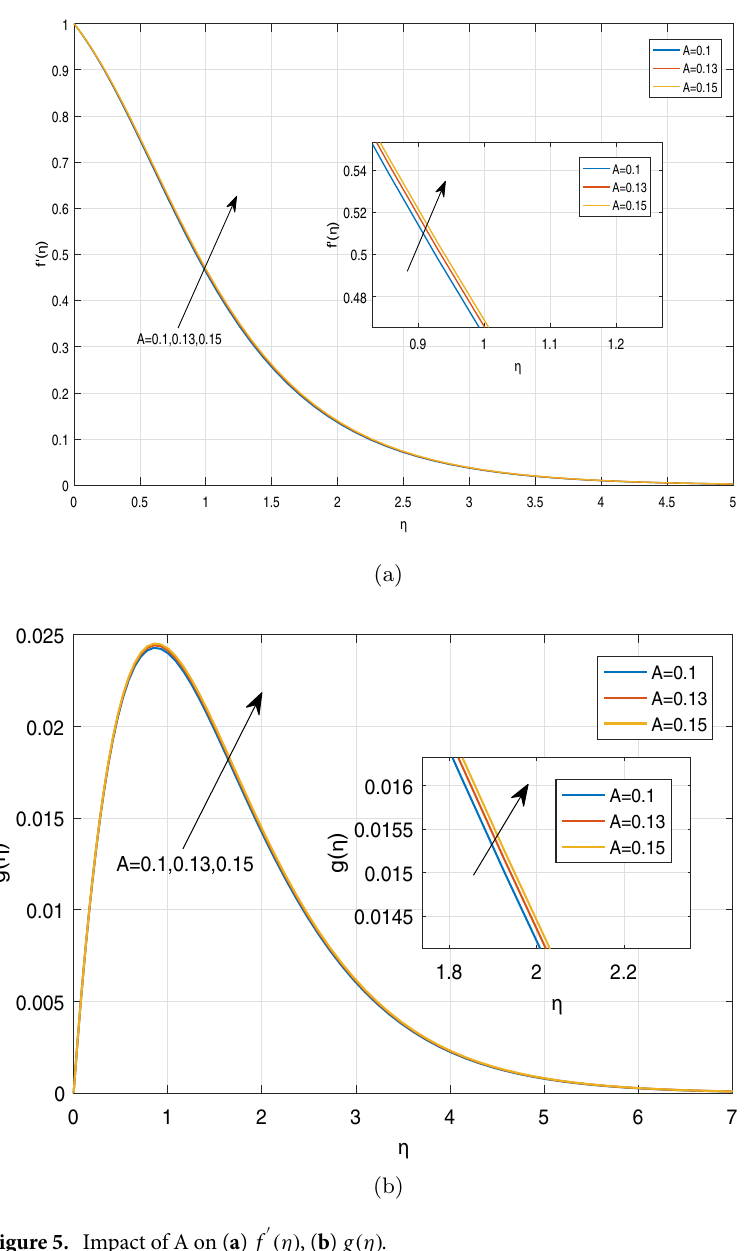
Figure 5. Impact of A on ( a ) f ′ (η) , ( b ) g (η)